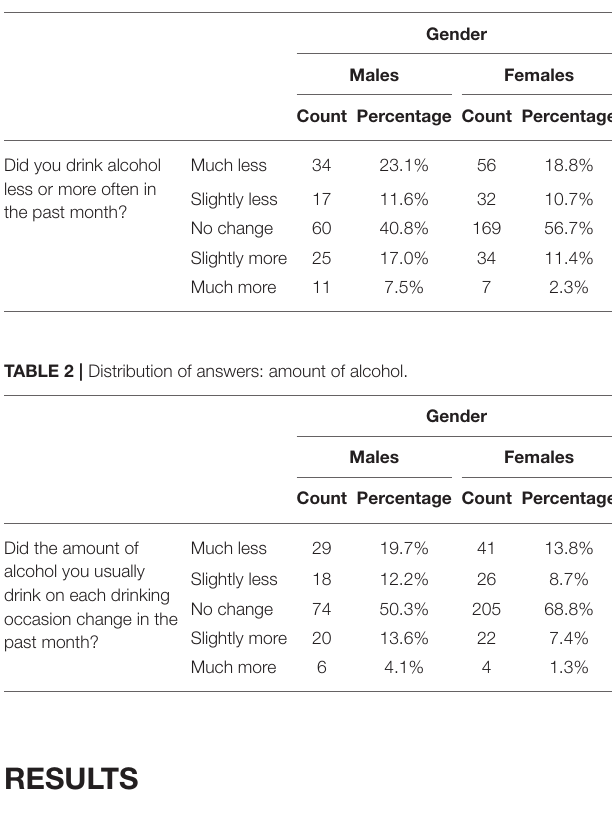
TABLE 1 | Distribution of answers: frequency of drinking.